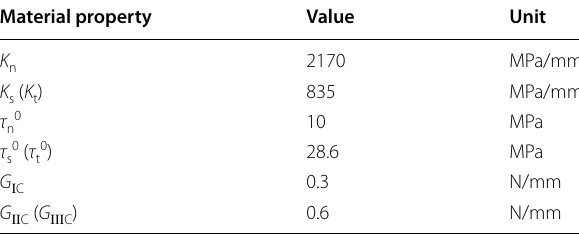
Table 2 Material properties of the cohesive interface